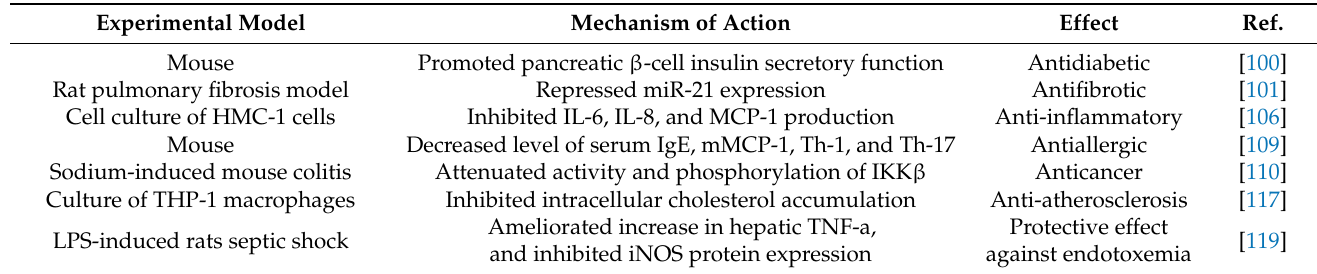
Table 2. Summary of the protective effects of baicalein in various experimental models. Experimental